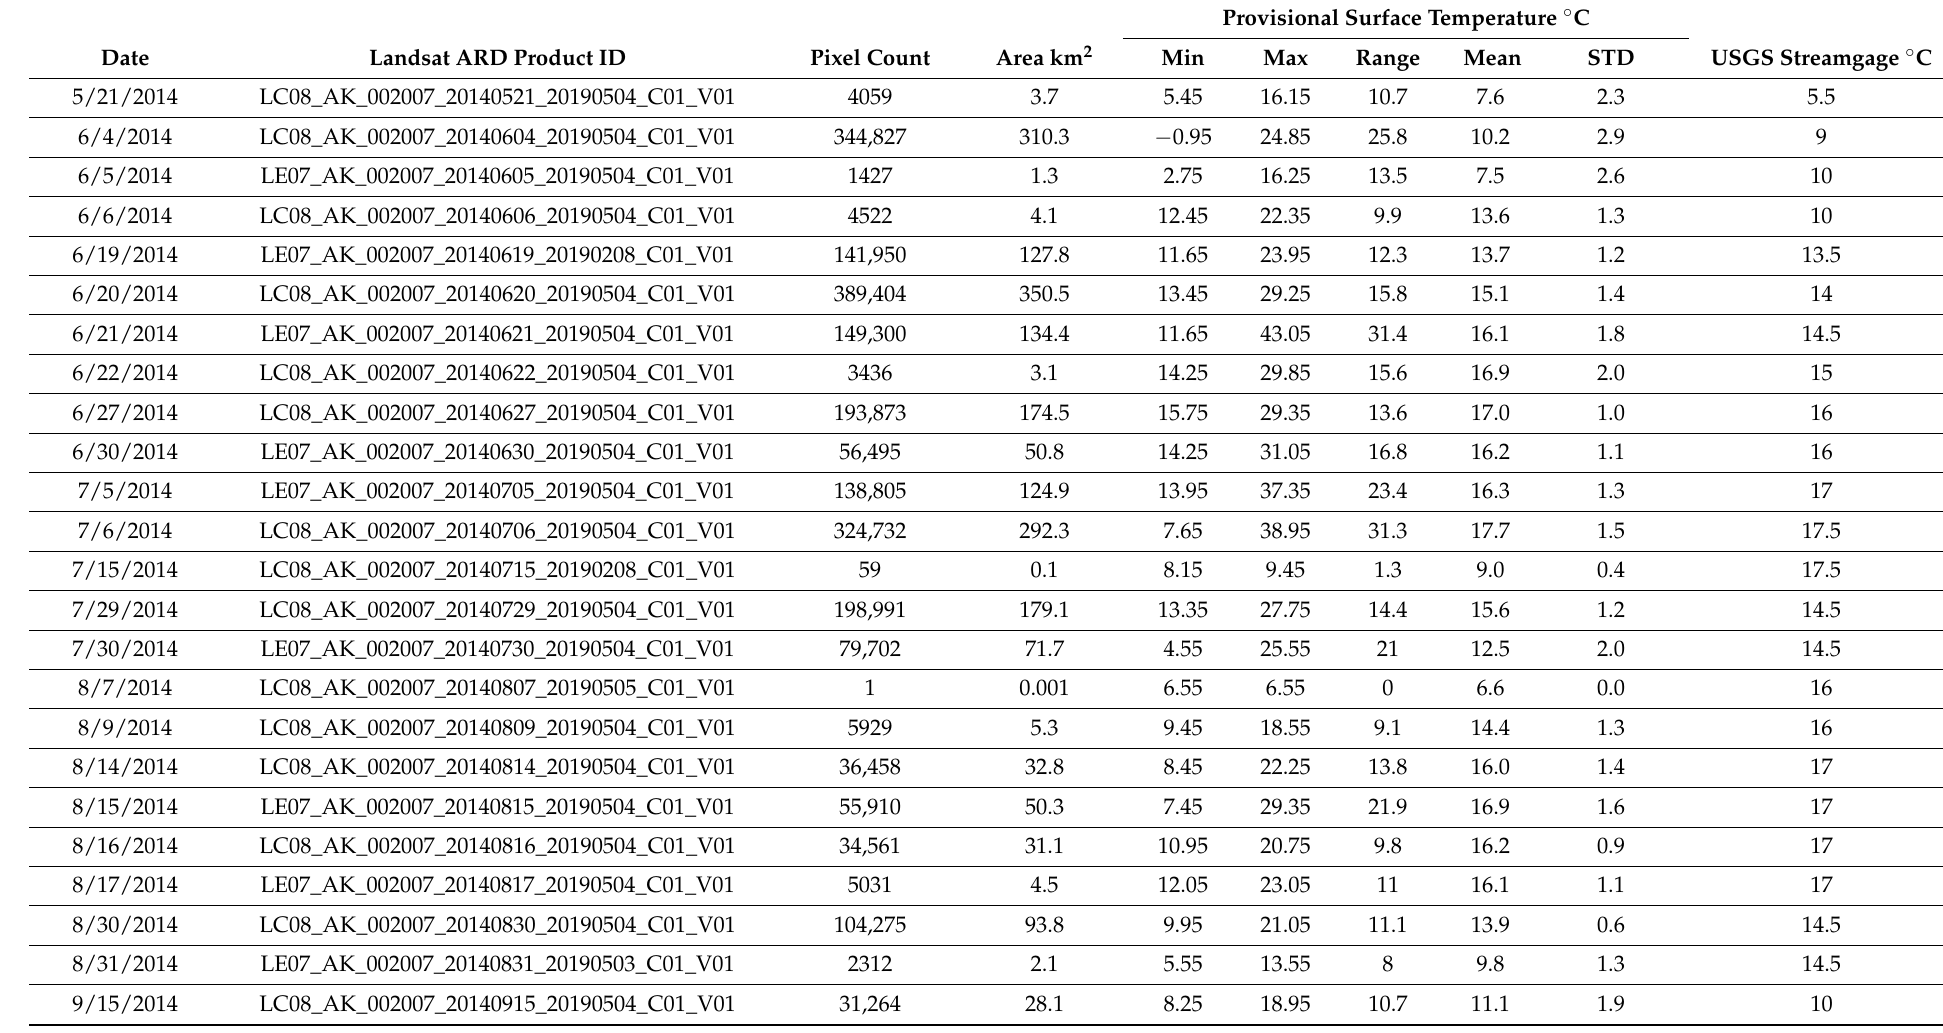
Table A1. Landsat ARD scenes utilized in this study with summary statistics that are reported for quality pixels utilized in each scene. Corresponding average daily water temperature recorded at the USGS Pilot Station streamgage are listed for